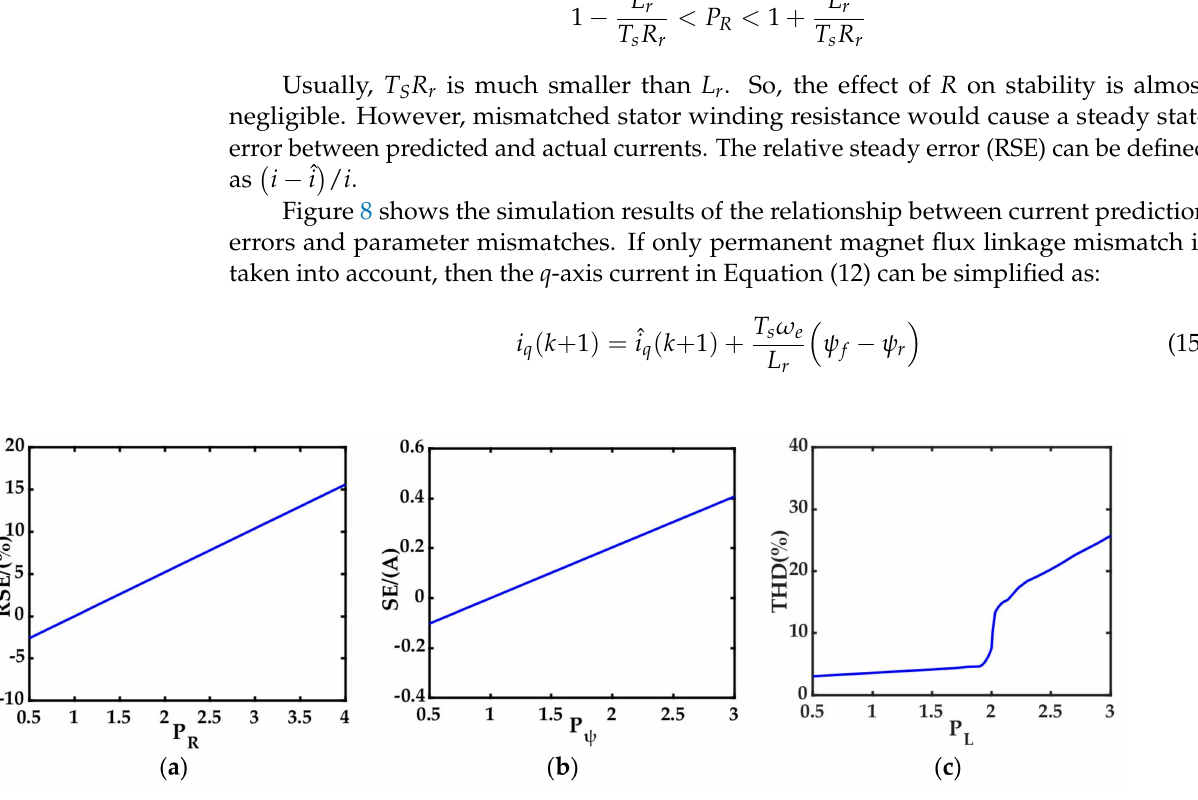
Figure 8. Simulation results of relationship between current prediction errors and parameter mismatches. ( a ) Relative steady state error under mismatched stator winding resistance. ( b ) Steady state error under mismatched permanent magnet flux linkage. ( c ) THD under mismatched stator